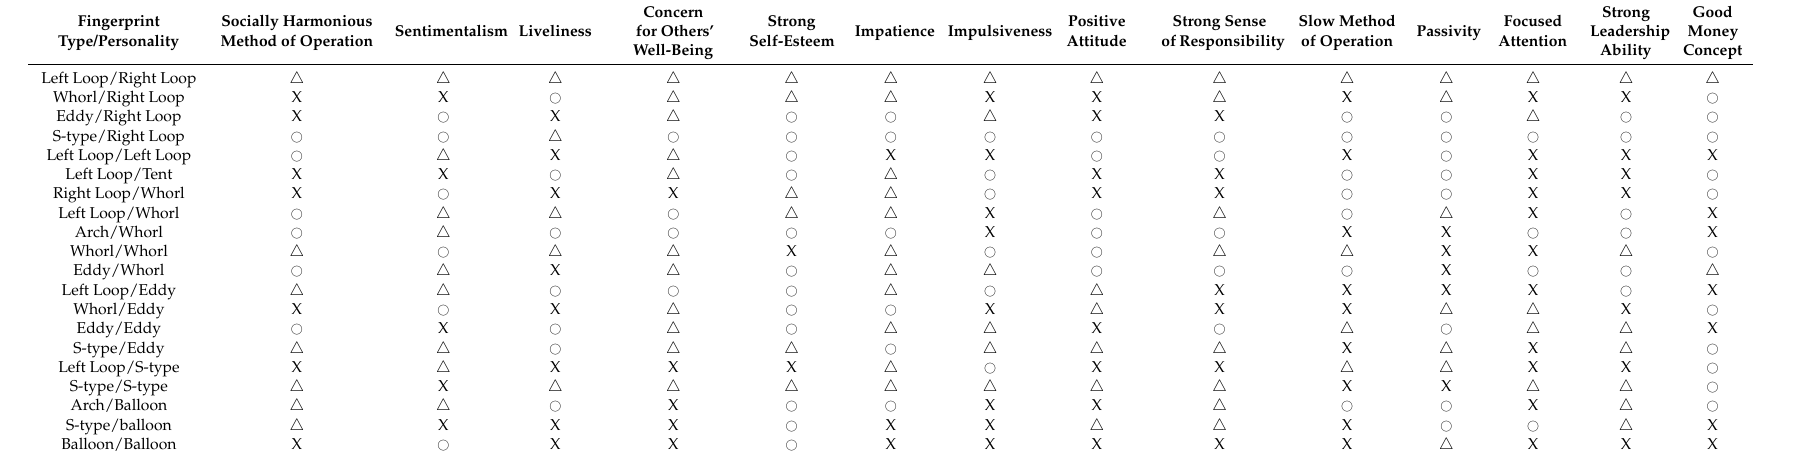
Table 3. Fingerprint types and personality